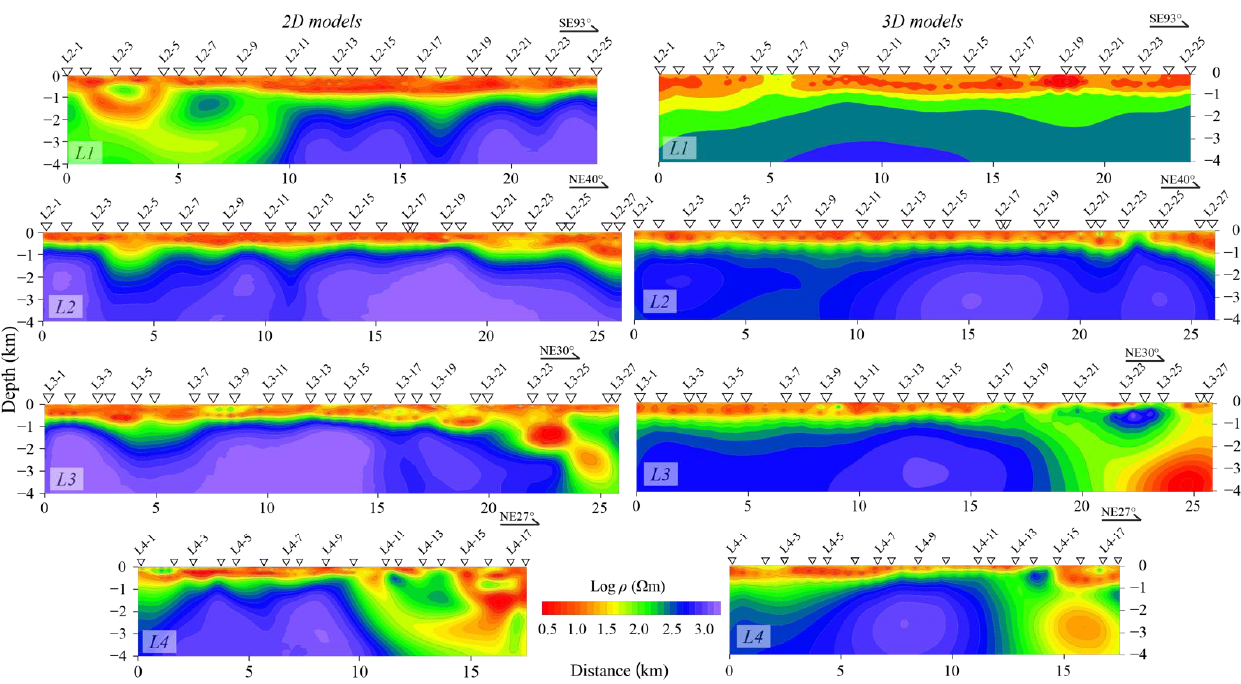
Figure 6. A comparison of resistivity models of the four MT profiles produced by 2D ( left panel ) and 3D ( right panel ) inversions, respectively. Triangles with labels are MT stations.